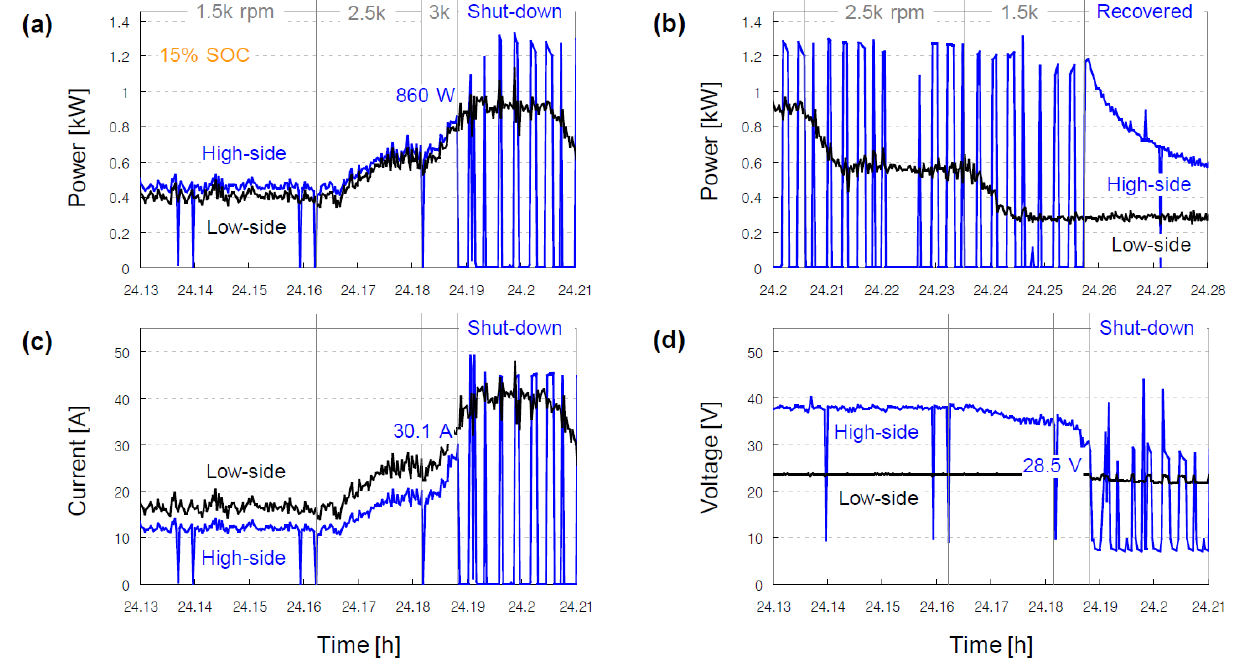
Figure 6. Results of integration tests performed to select the lower limit of the SOC. ( a , b ) Power, ( c ) Current, and ( d ) Voltage versus time. The power oscillations observed in the fuel cell are indicative of its repeating attempts to reconnect the